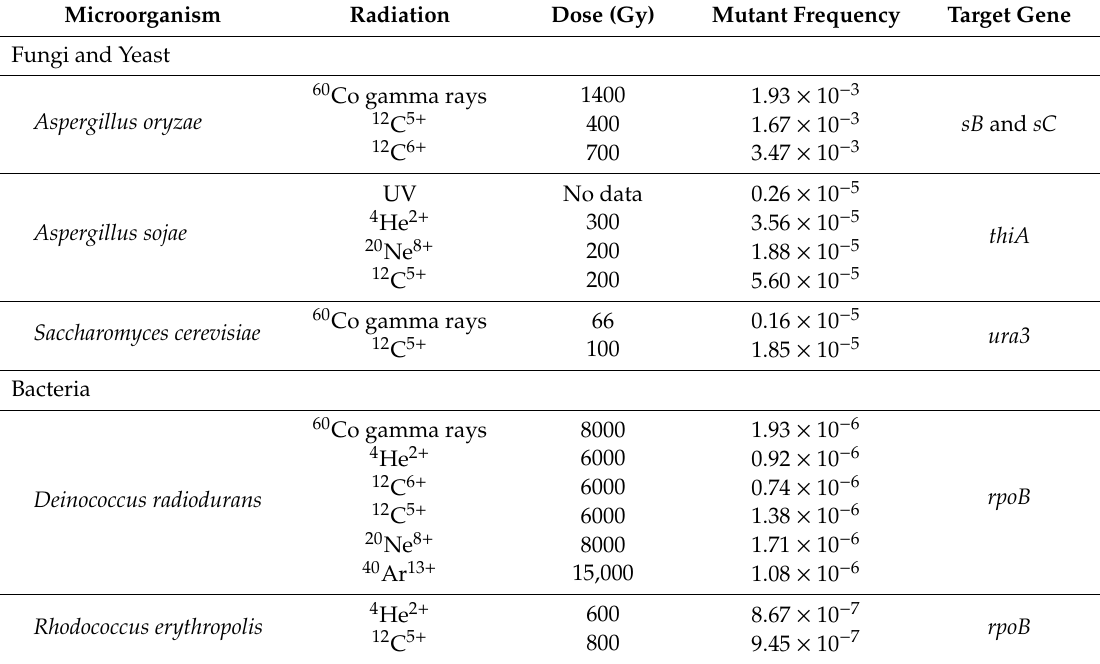
Table 2. Comparison of the highest mutant frequency.